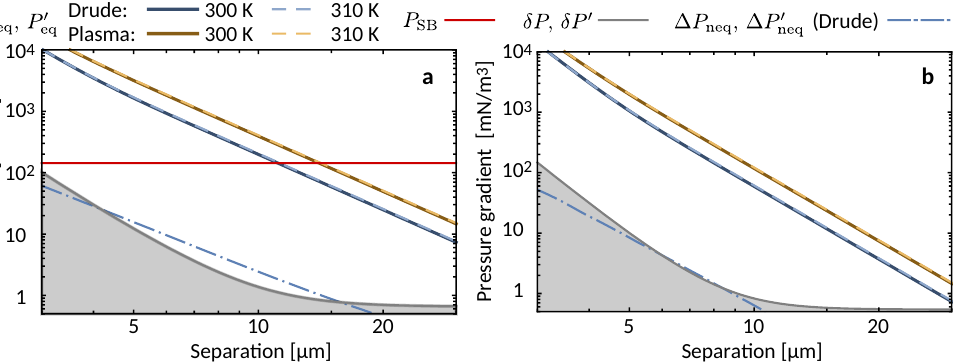
Figure 10. Comparison of the magnitude of the various contributions to the Casimir pressure ( a ) and its gradient ( b ) out of thermal equilibrium for temperatures T 1 = 300K and T 2 = 310K of the upper and lower plates, respectively. The experimental errors δ P and δ P (cid:48) are given for